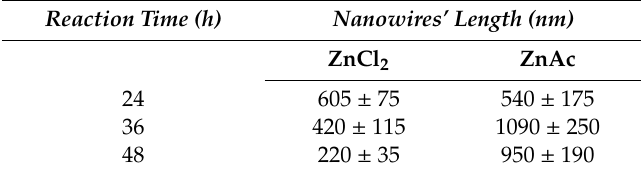
Table 1. Evolution of the average of nanowires’ length with the reaction time. Reaction Time (h) Nanowires’ Length